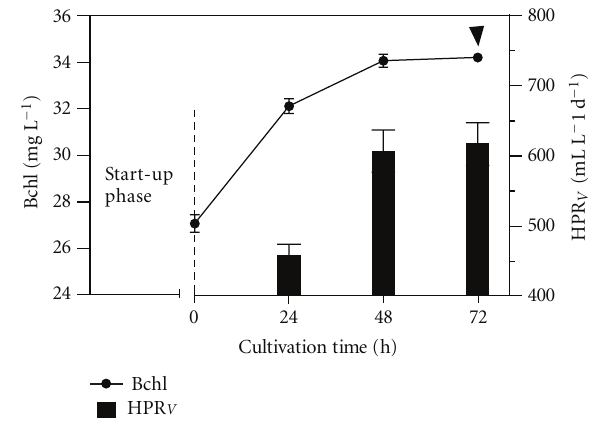
Figure 4: Changes in the Bchl concentration versus the cultivation time and relative HPR V achieved in time, under SCR, at 30 ◦ C with an irradiance of 480 Wm − 2 . The HRT was 360 hours. The arrow indicates the cultivation time when we withdrew 50mL of culture volume from the reactor and replaced with an equal volume of fresh